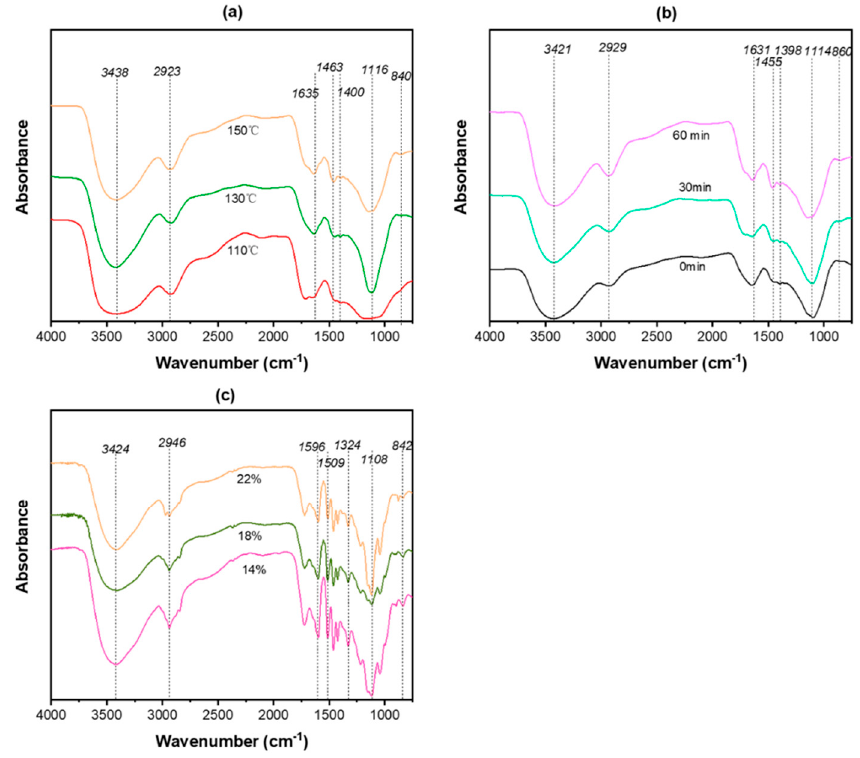
Figure 7. FT-IR spectra of alkali lignin under different reaction temperatures ( a ), holding times ( b ) and amounts of NaOH ( c ).